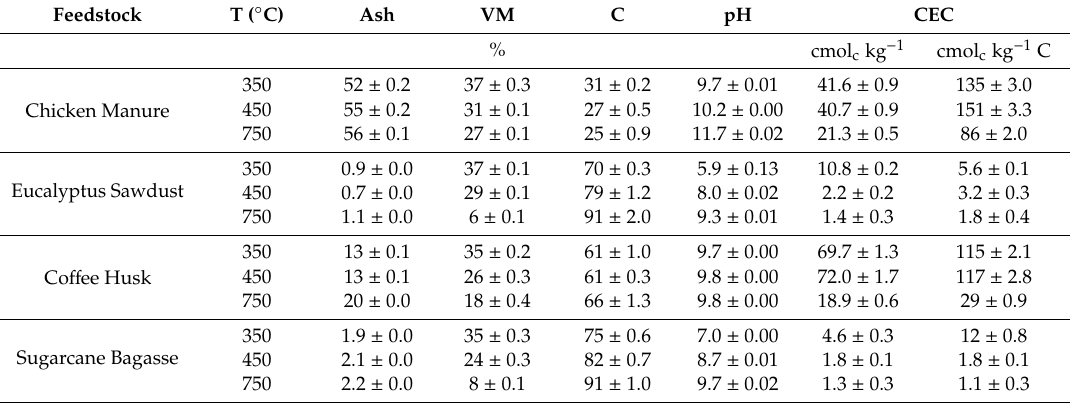
Table 2. Chemical and physicochemical properties of the biochars produced from four feedstocks pyrolyzed at 350, 450 and 750 ◦